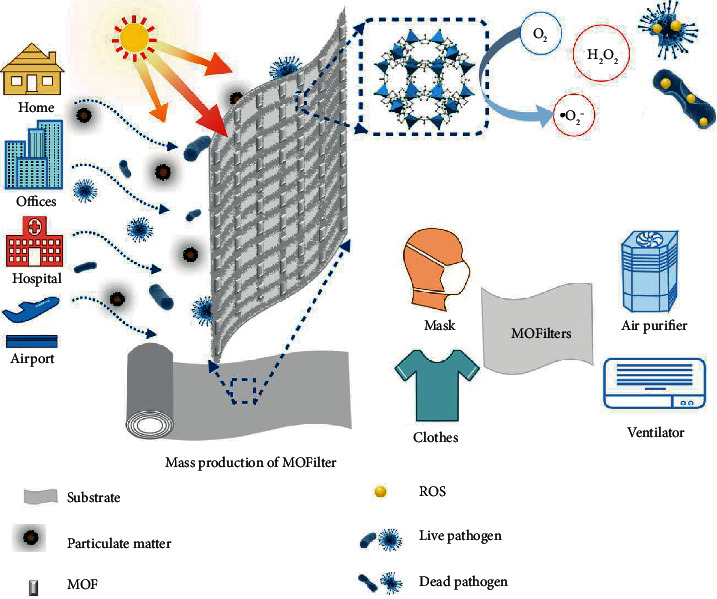
Schematic representation of MOF-based filter (MOFilter) for integrated air cleaning. Reproduced with permission from Ref. [196]. Copyright 2019, Springer Nature.